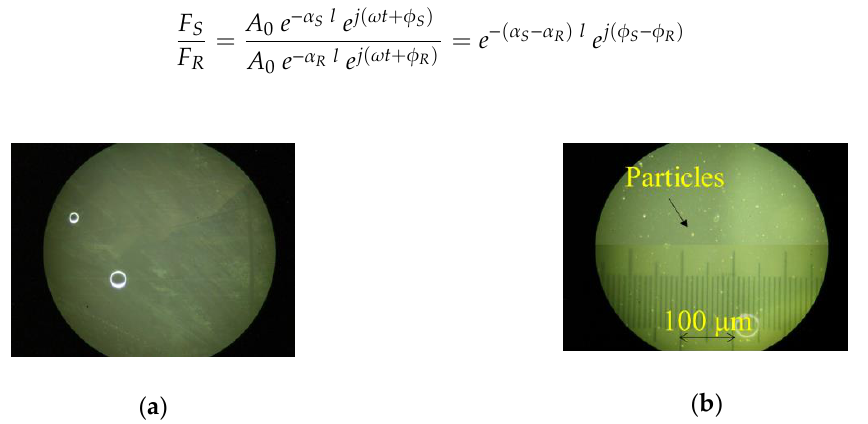
Figure 3. Observation results of ( a ) new and ( b ) used engine oils using the microscope.